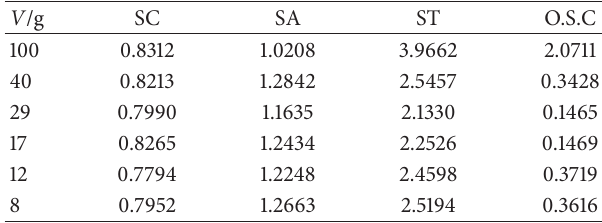
Table 2: Data of the variation of liquid volume test.